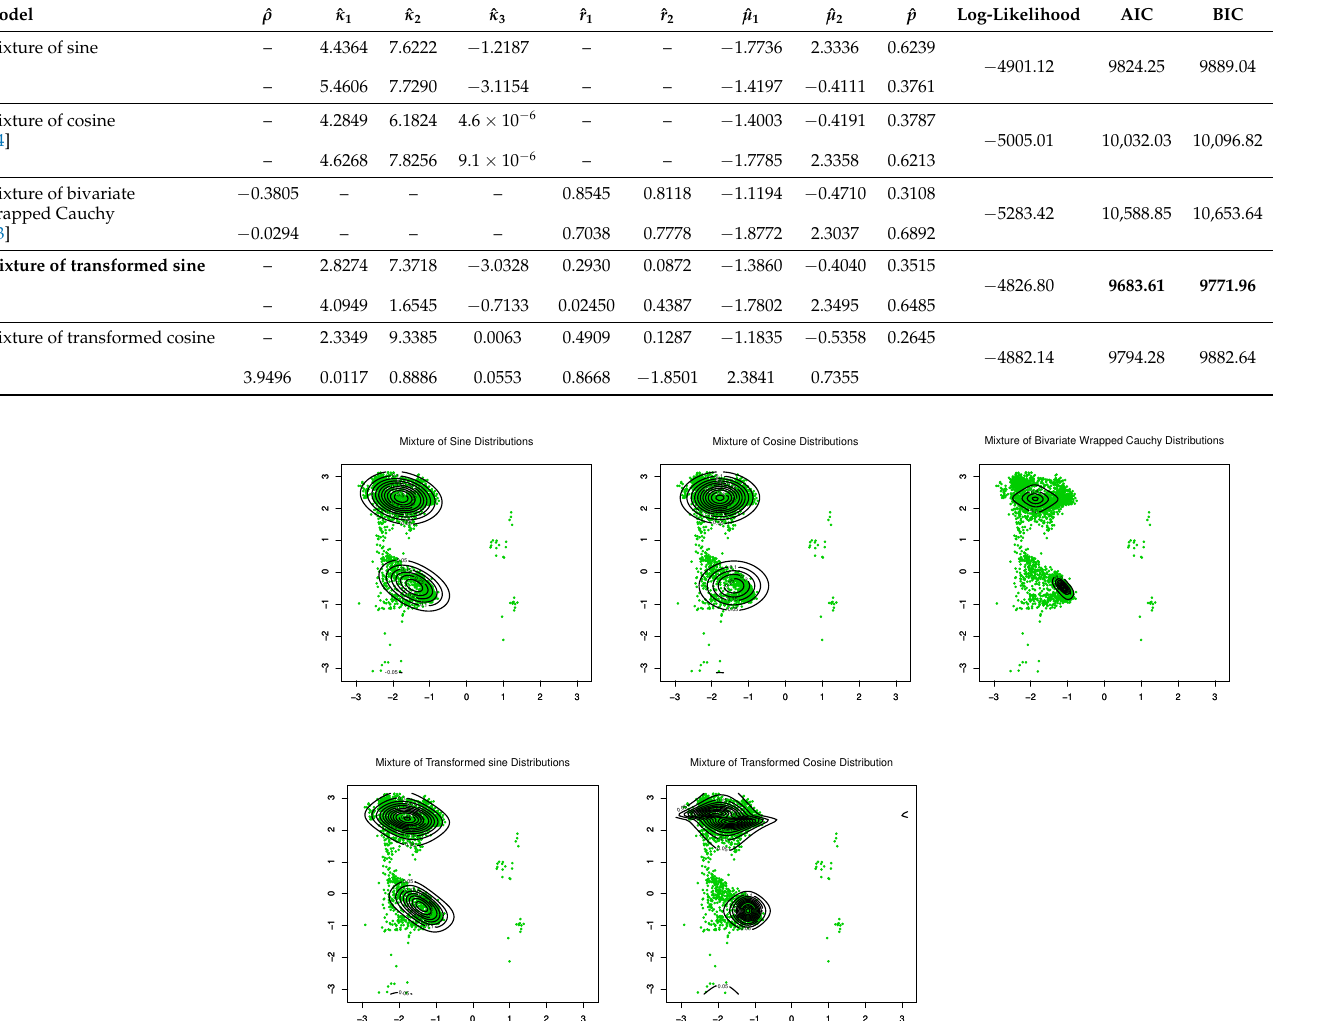
Table 3. Maximum likelihood estimates and corresponding log-likelihood, AIC, and BIC for TCBIG.VAL.right ( n = 2673).